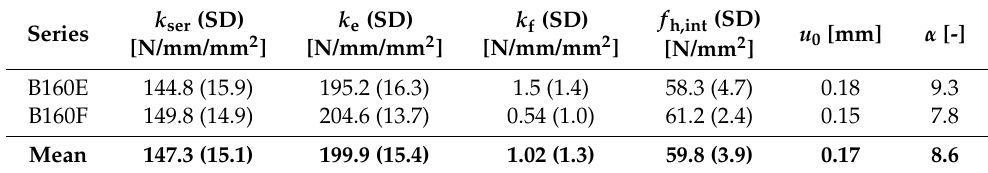
Table 8. Mean values of important parameters from embedment tests using beech LVL [33,34]. k ser Series